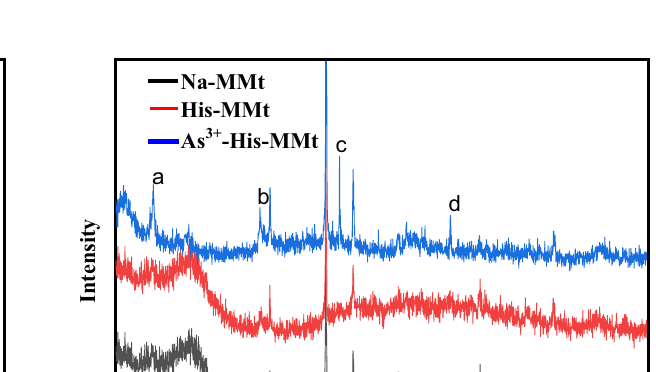
Fig. 3 SEM images of a Na-MMt b His-MMt